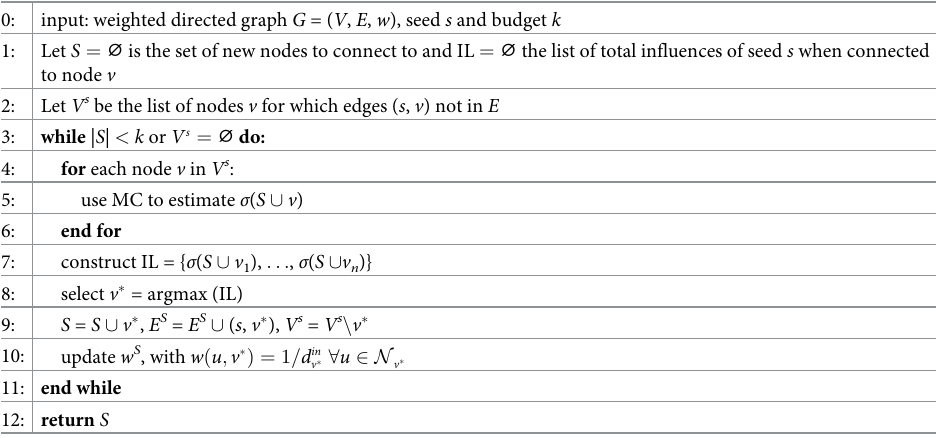
Table 1. GLIM: Greedy algorithm for edge selection in